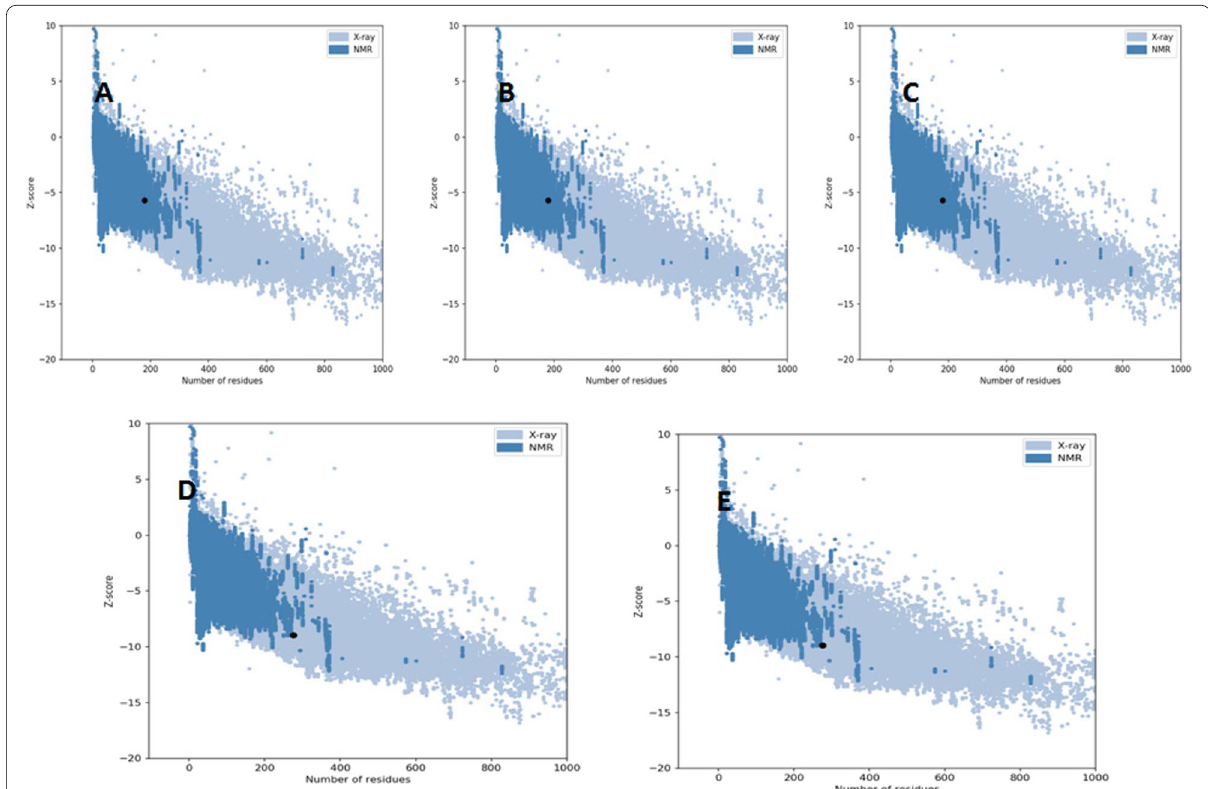
Fig. 4 Z-plots for all the docked complex structures. A 1AQD-GKSFELNQAARAVTQ. B 1AQD-LHRYSYKLAGVNQVD. C 1AQD-RYSYKLAGVNQVDVV. D 1XR9-ITLKLLHRYSYKLAG. E